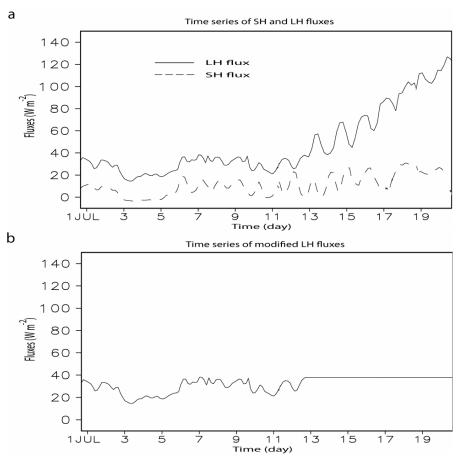
Fig. 2. Time-height cross section of (a) potential temperature large-scale forcing (Kday − 1 ) and (b) humidity large-scale forcing (gkg − 1 day − 1 ) for the CSRM run. Contours start at 0 and the con- tour interval is 5.